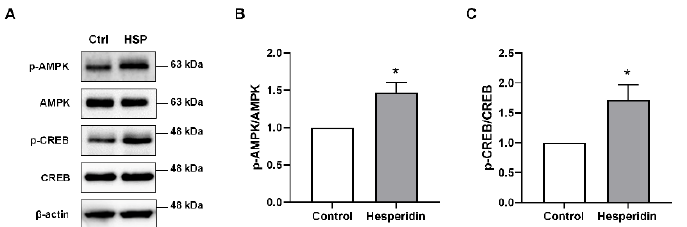
Figure 2. The effects of hesperidin on AMPK/CREB signaling in neurospheres. To prove the neuro- genic effects of HSP, we measured AMPK and CREB protein levels in vitro. Phosphorylated/total AMPK and CREB were analyzed by western blot. ( A ) Representative images of AMPK and CREB in neurosphere lysates. ( B , C ) Quantification of AMPK ( B ) and CREB ( C ) expression. Statistical analysis included Student’s t test. * p < 0.05 compared with the vehicle-treated control group. Data are shown as mean ± SEM ( n = 3 per group).